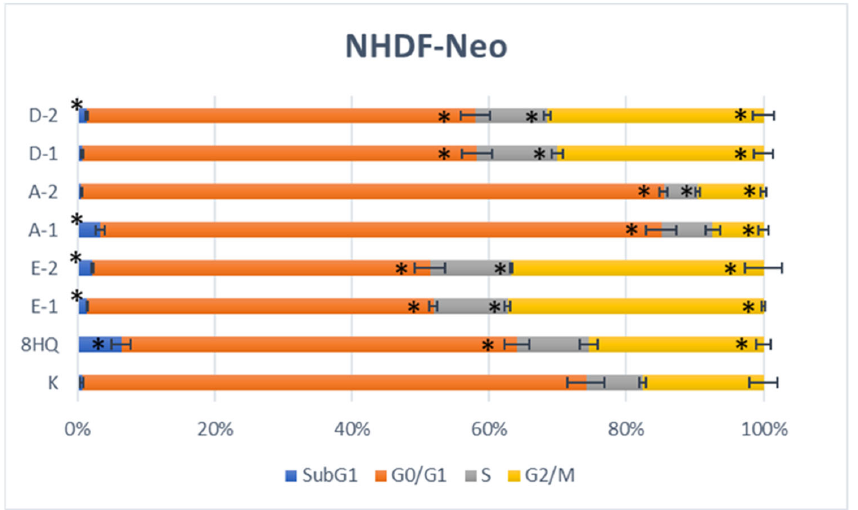
Figure 8. Flow cytometry analysis of HCT-116, MCF-7, and NHDF-Neo cell cycle distribution after incubation for 24 h with test compounds used in their IC 50 doses. Means ± SD from three independent experiments. * p ‐ value < 0.05, in comparison to the control.